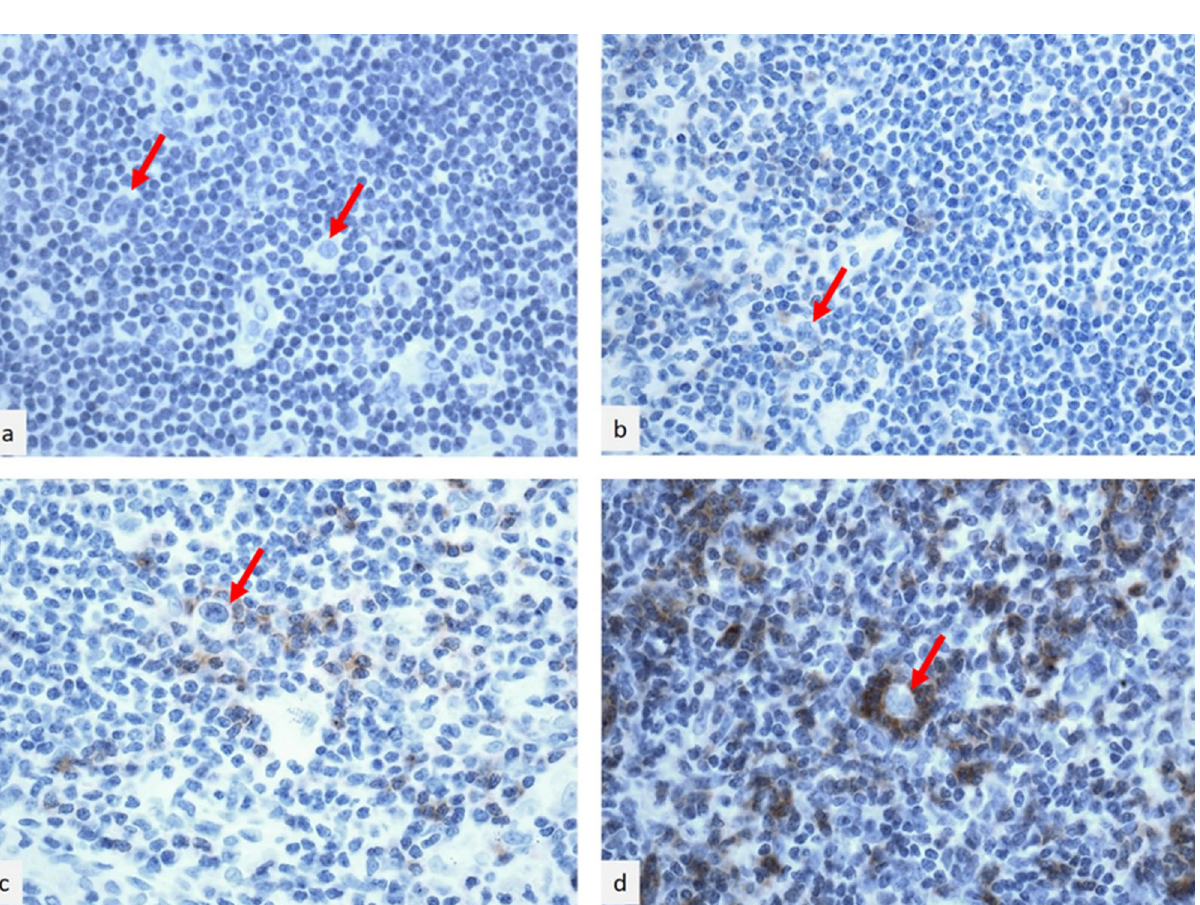
Figure 1. TIGIT immunohistochemistry in classical Hodgkin lymphoma. High power fields, hematoxylin counterstained. ( a ) Score 0: no evidence of lymphocytes with staining within the tumor environment; ( b ) score 1: sparse, faintly stained lymphocytes within the tumor environment, near the HRS cells; ( c ) score 2: presence of a discrete quote of lymphocytes with moderate membrane staining around the HRS cells; ( d ) score 3: evidence of a circle of lymphocytes with intense membrane staining surrounding the HRS cells. Red arrows indicate HRS